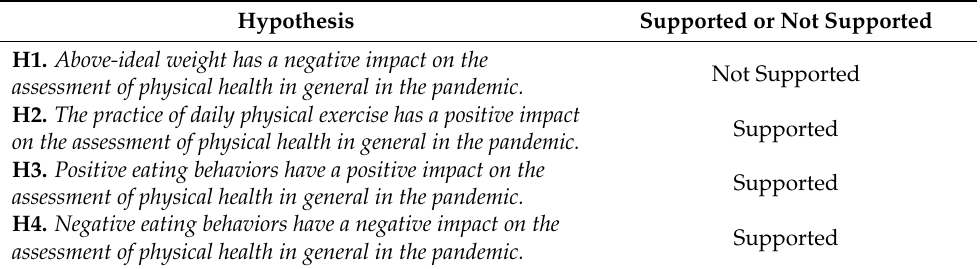
Table 6. Summary of